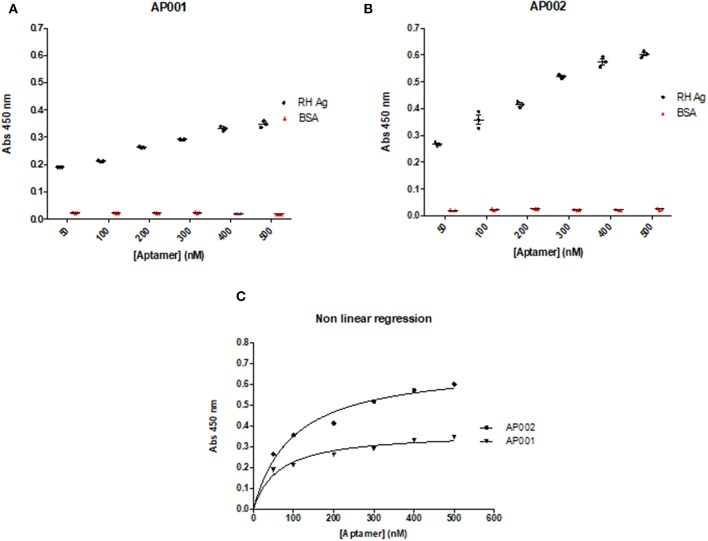
Concentration and Binding affinity of AP001 (A) and AP002 (B) aptamers. Ag RH was used as a positive control and different concentrations of each aptamer (from 50 to 500 nM) were used. BSA was used as a negative control. The dissociation constant (Kd) was calculated through a non-linear regression to define the affinity of aptamers to the RH Ag, obtaining a Kd of 62.7 nM for AP001 and a Kd of 97.7 nM for AP002 (C).